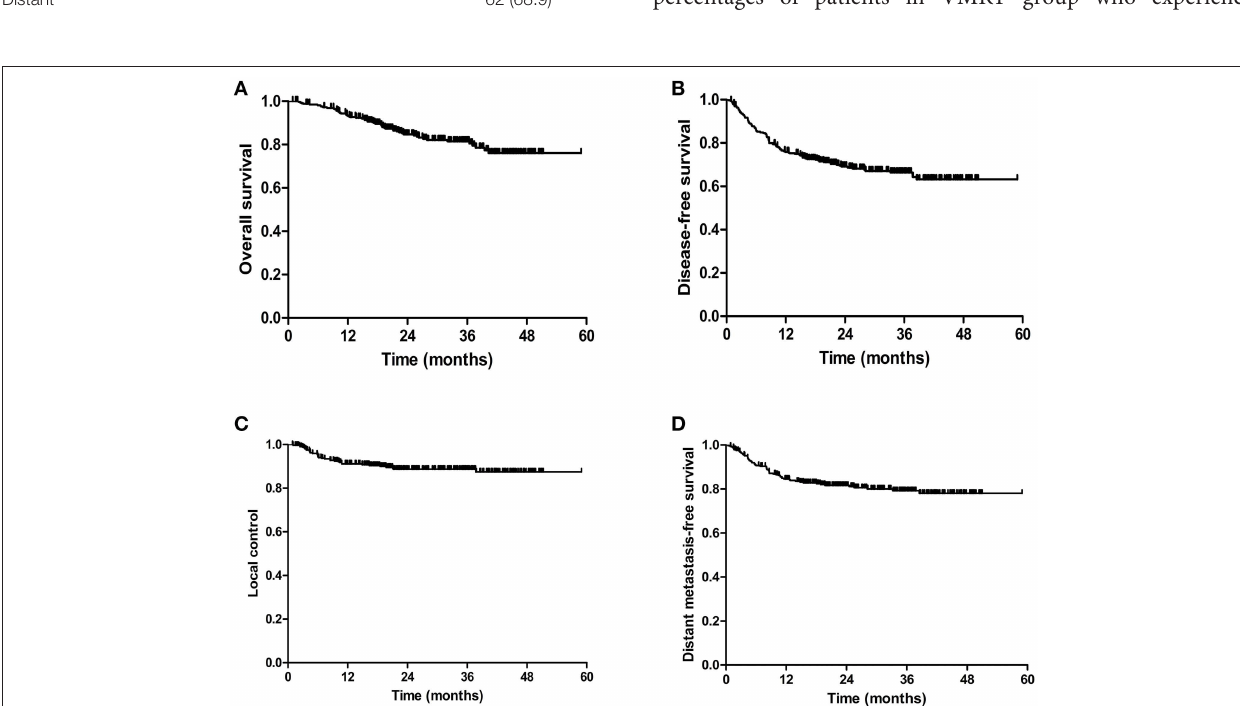
FIGURE 1 | Kaplan-Meier estimated of the overall survival (OS) (A) , disease-free survival (DFS) (B) , local control (LC) rates (C) , and distant metastasis free survival (DMFS) (D) of cervical cancer patients treated with VMAT.